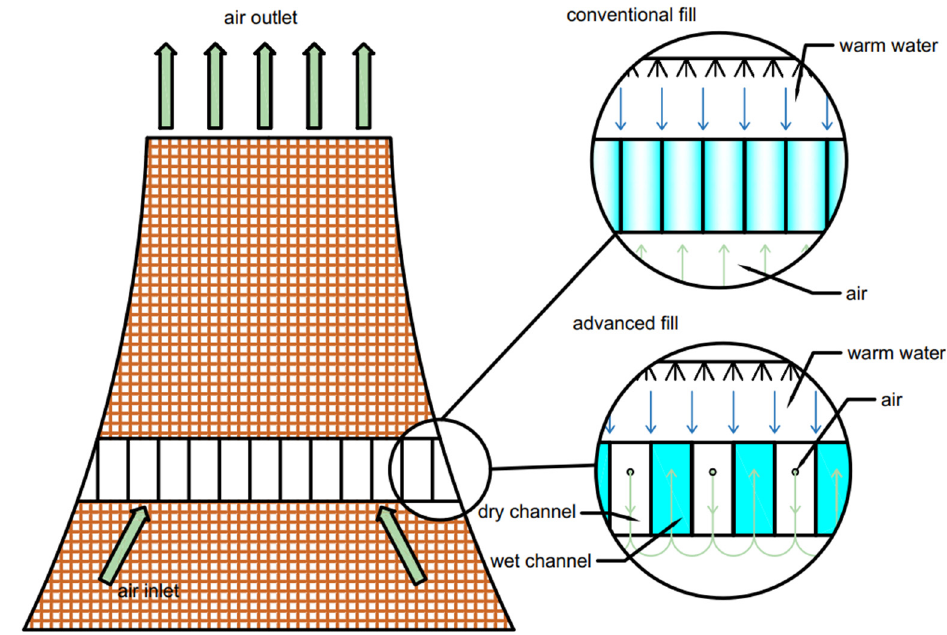
Figure 12. Large-scale cooling tower with the M-cycle [63].